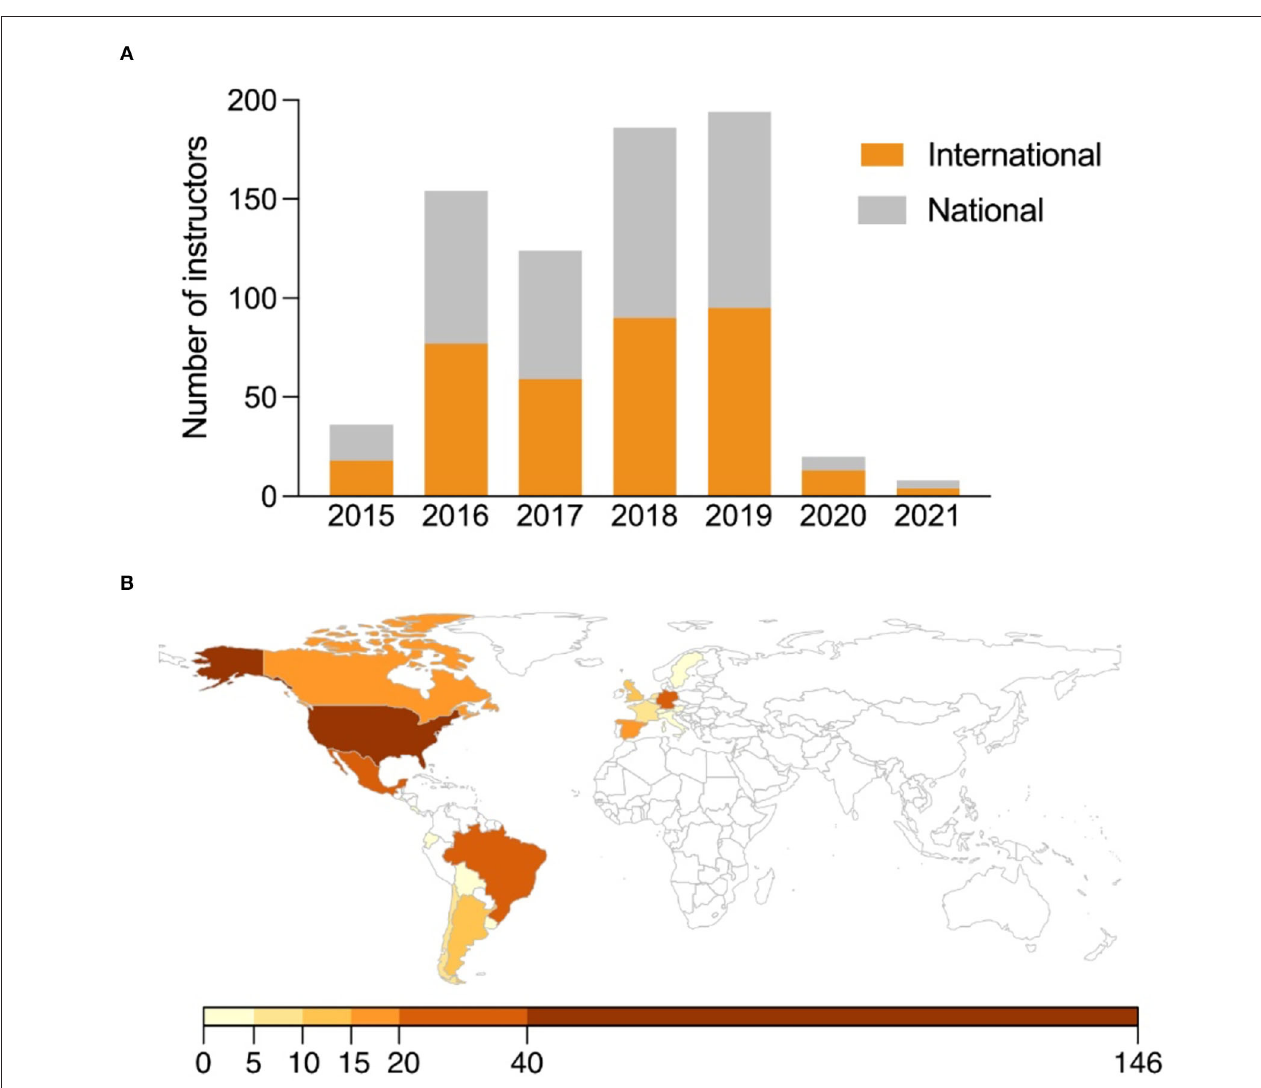
FIGURE 3 | International instructor involvement and distribution. (A) Total number of national and international instructors involved in the Program annually from 2015 to 2021. (B) Global distribution of international instructors defined by location of work or study during the year their corresponding Club took